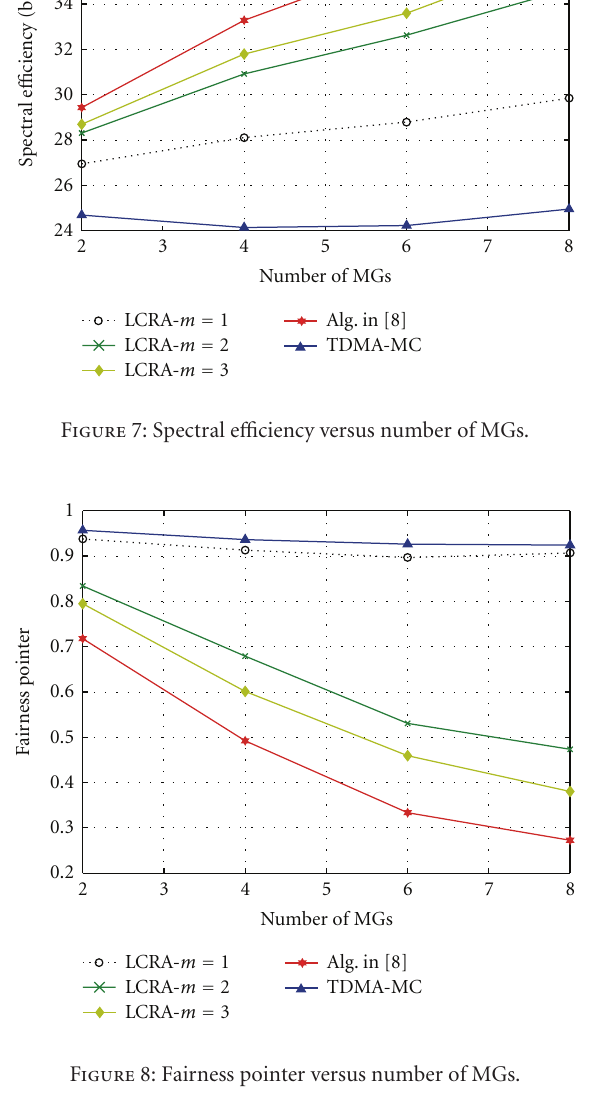
Figure 10: Fairness pointer versus SNR—no pathloss di ff erence be- tween